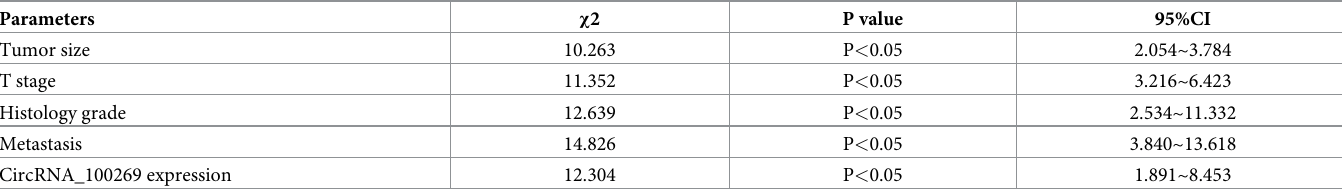
Table 2. Influence factors of the prognosis in GC patients were identified.